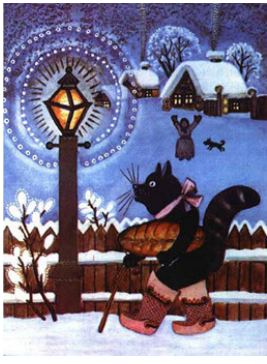
Figure 5. Koten’ka Kotok. Illustra - tion in a children’s book. Artist Y. Vasnetsov